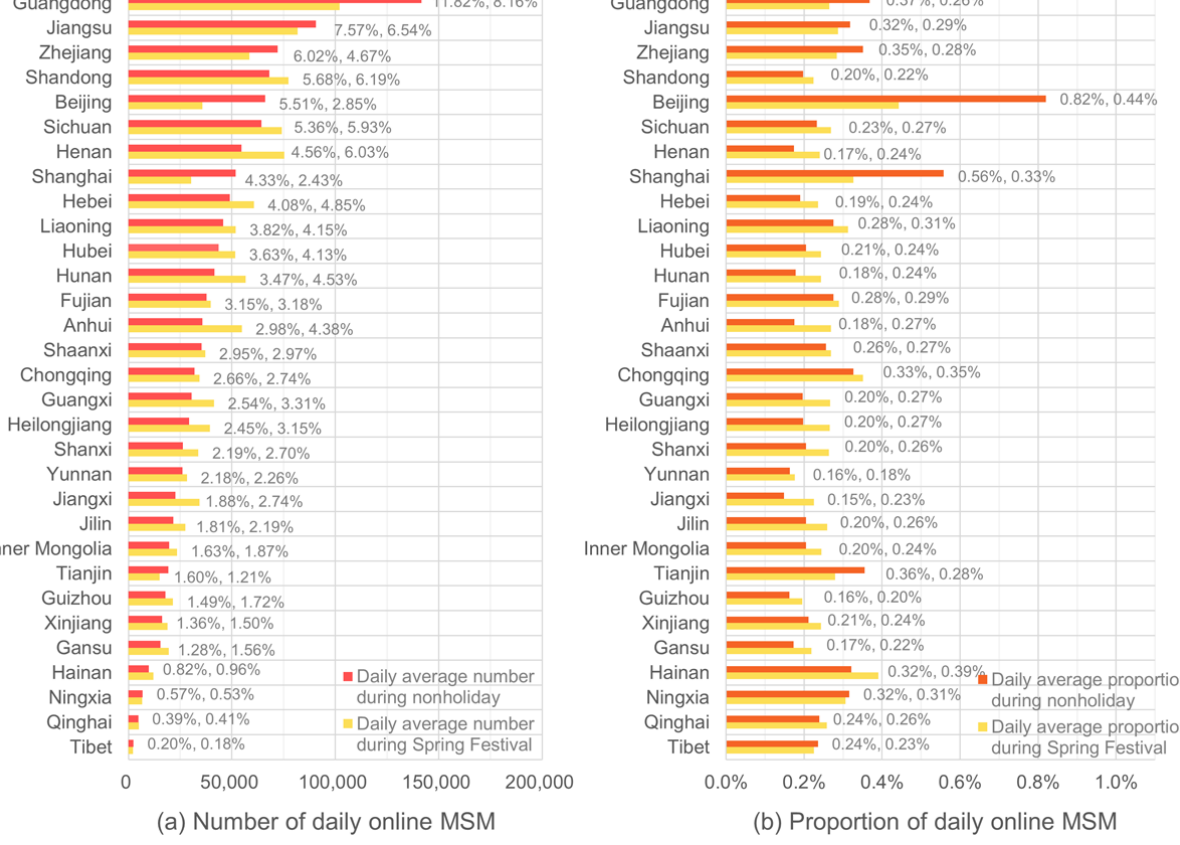
Figure 1. Provincial daily number and proportion of social networking men who have sex with men (MSM) from the Blued app. Numbers after the bars in (a) denote the percent of daily online MSM among the whole country; numbers after the bars in (b) denote the proportion of daily online MSM among local adult men aged 18 to 64 years; the two numbers after each bar are for nonholiday and holiday respectively.